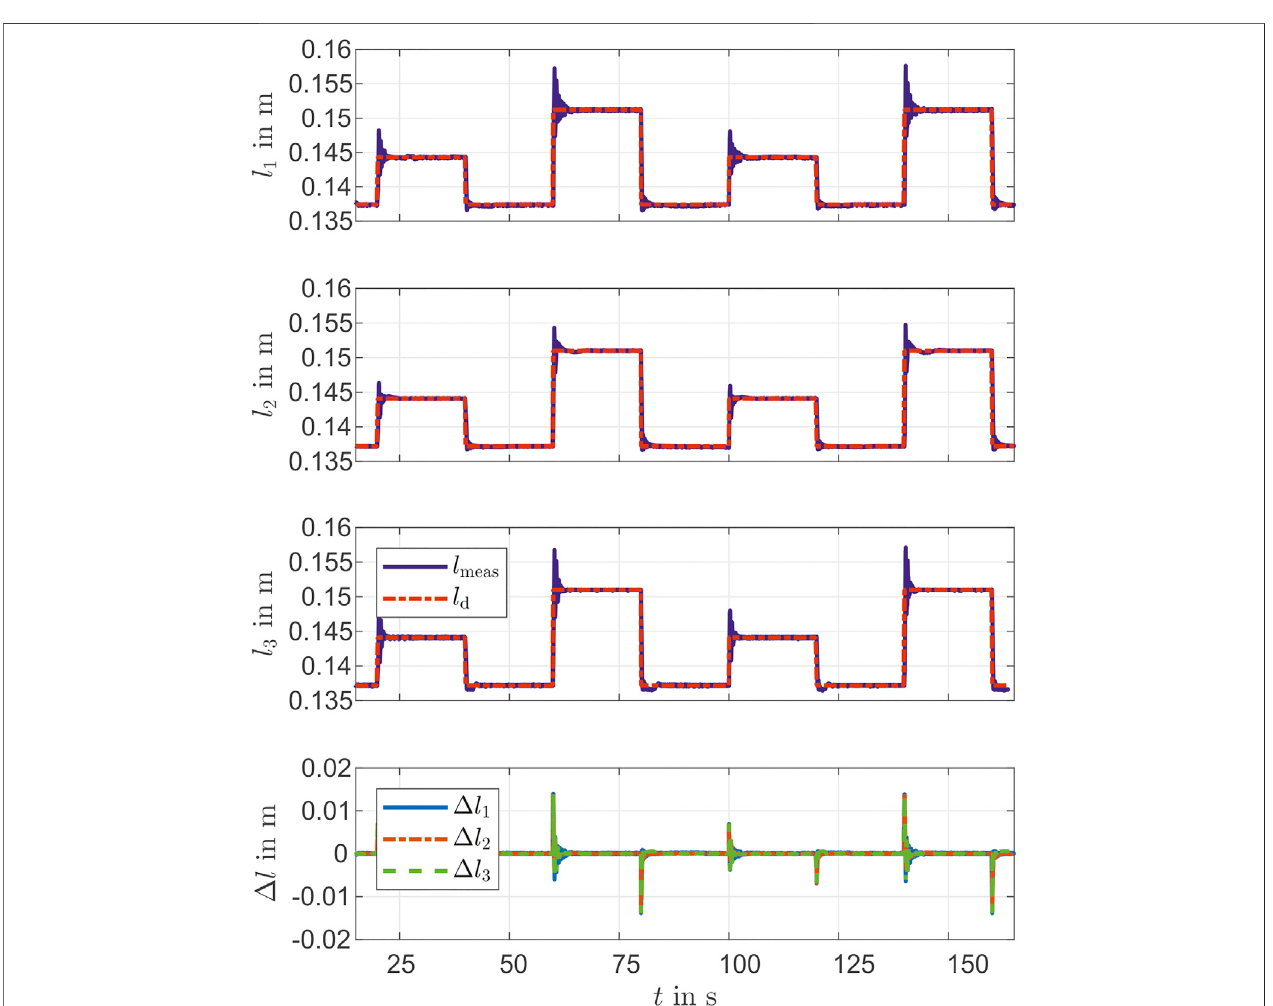
FIGURE 6 | Step response of PID controllers of chambers ’